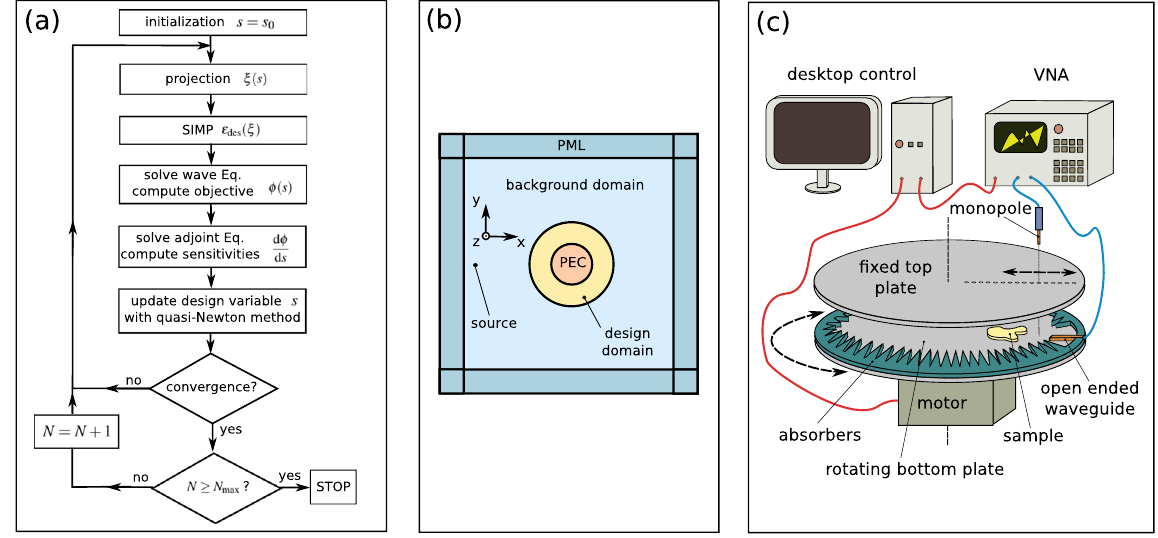
Figure 5. Numerical and experimental methods. ( a ) Optimization algorithm workflow. ( b ) Computational setup for the FEM optimization problem. ( c ) Measurement